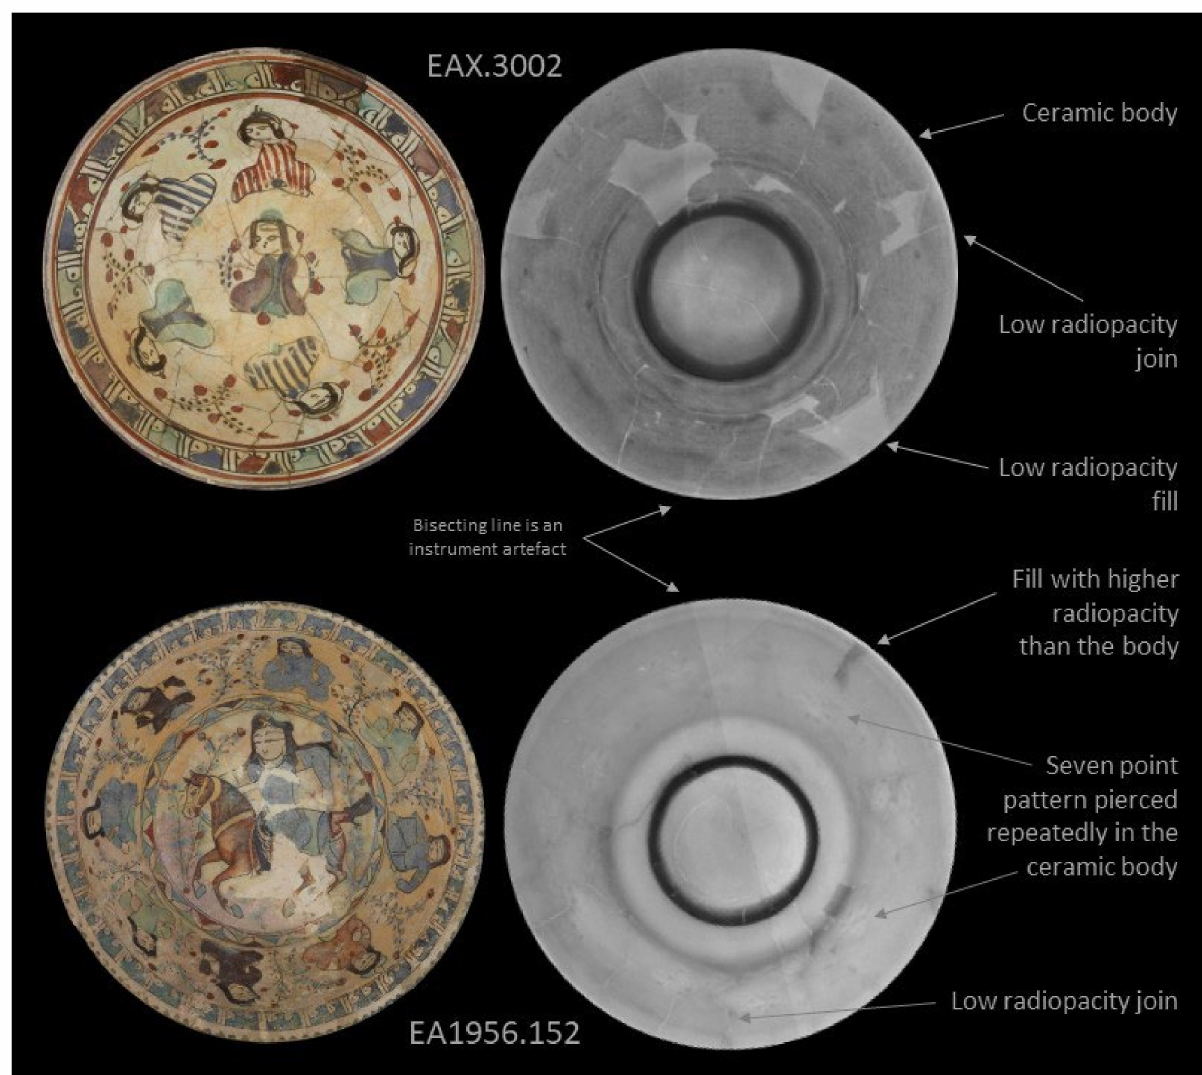
Figure 5. Results of digital photography on the left compared to digital radiographs on the right for EAX.3002 and